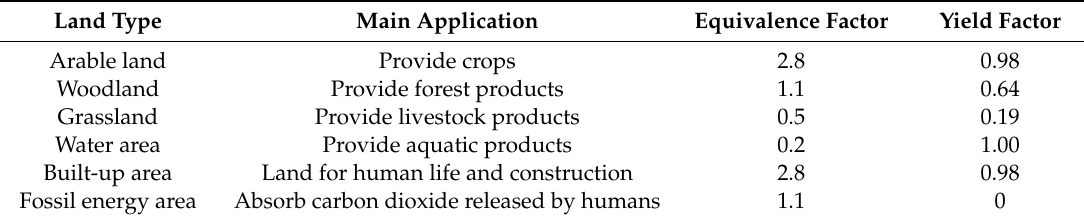
Table 1. Description of the land types in the ecological footprint (EF)